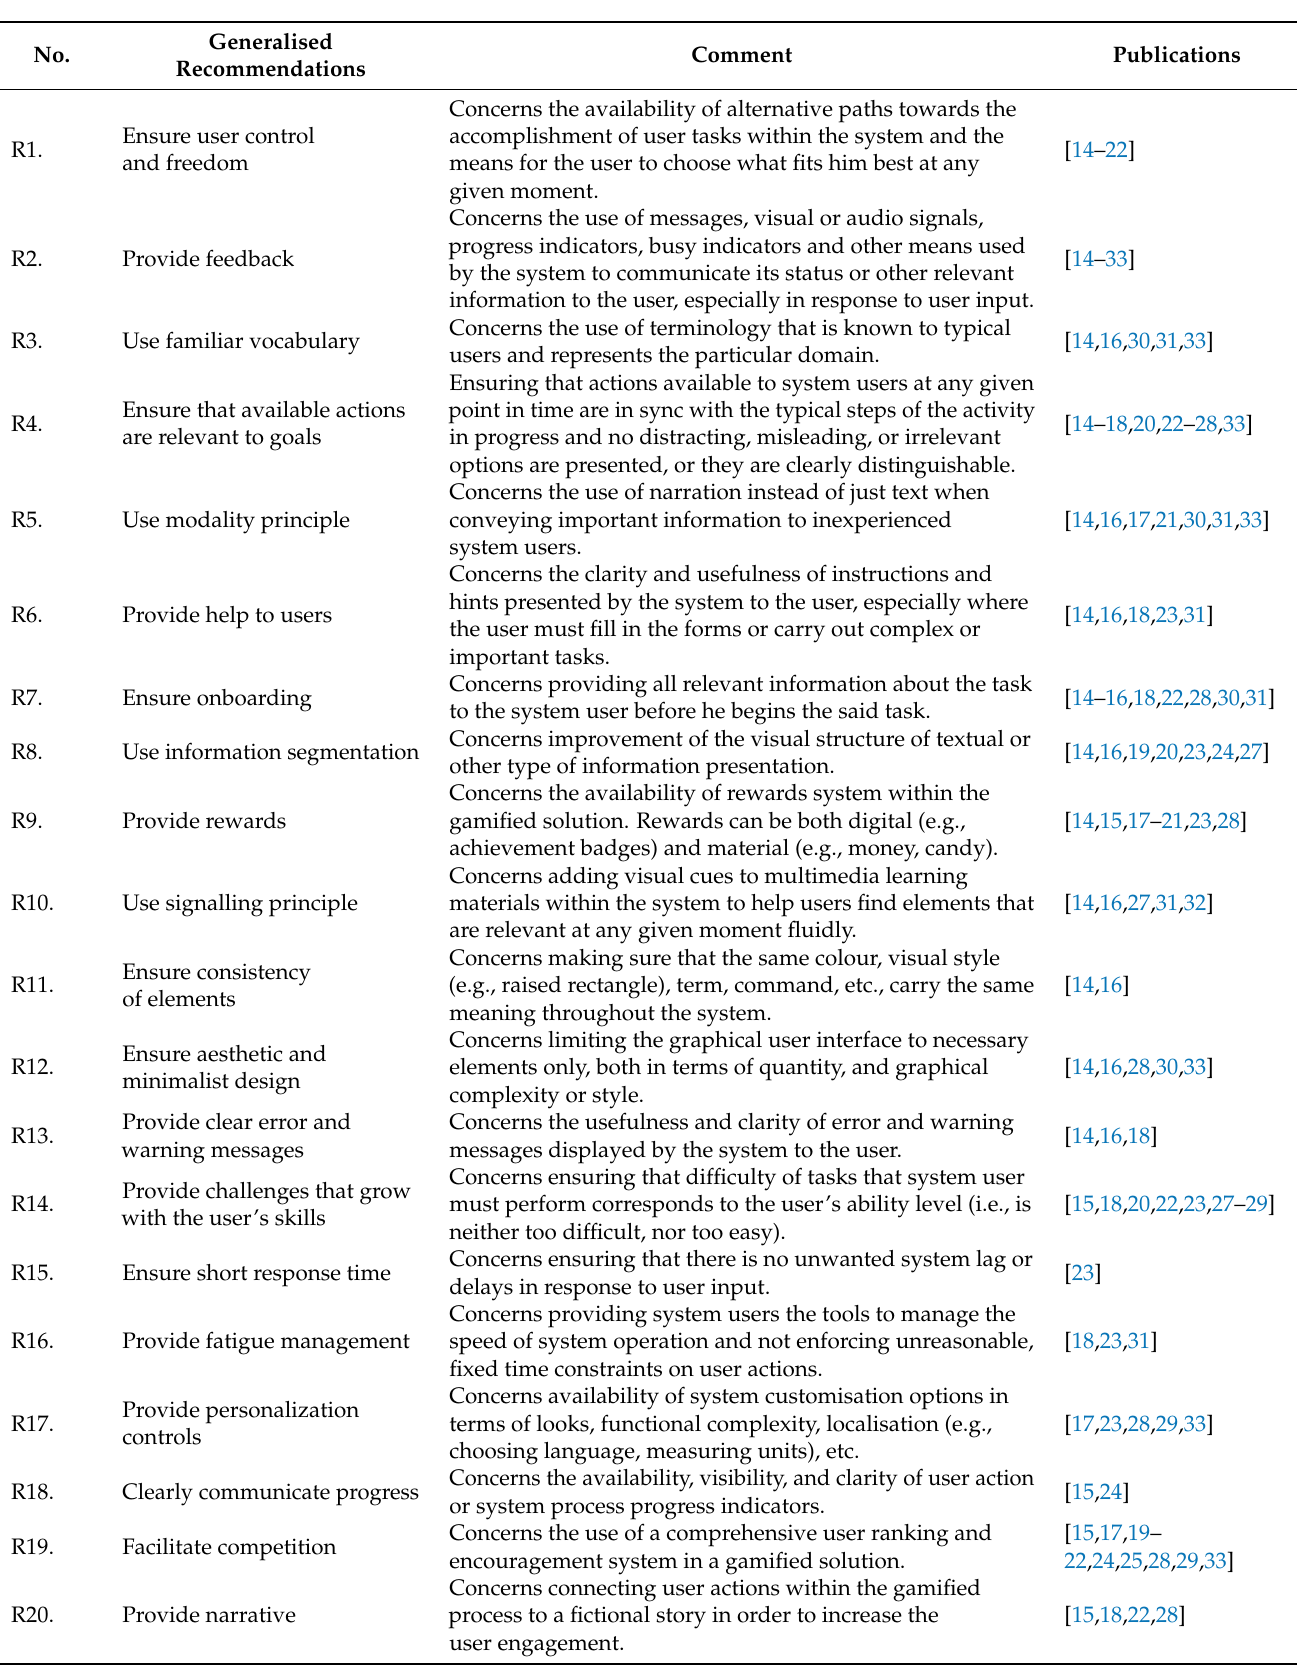
Table 2. Recommendations found in the selected